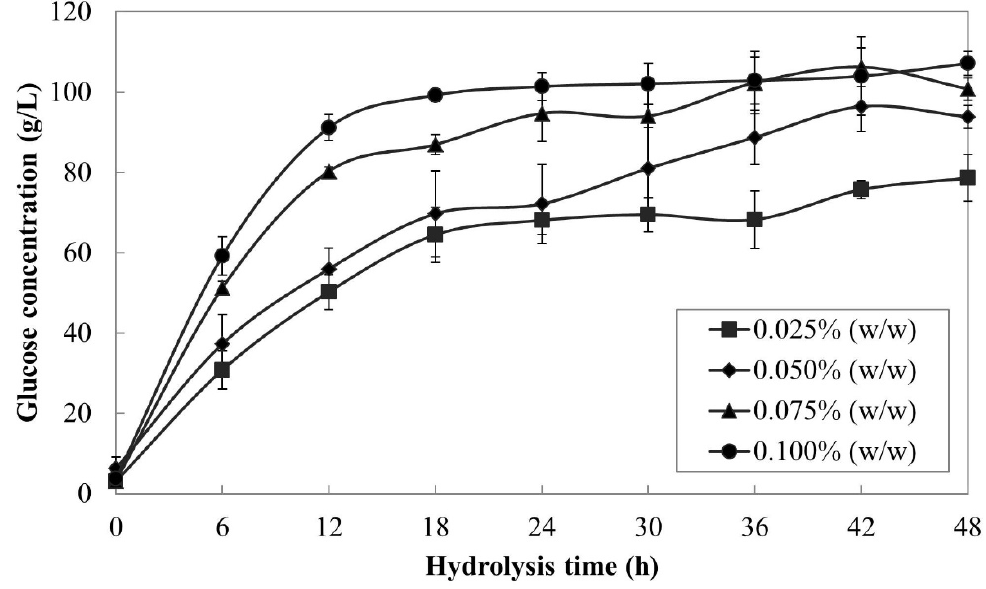
Figure 2. The e ff ect of StargenTM002 at concentrations of 0.025% (squares), 0.050% (diamonds), 0.075% Figure 2. The effect of StargenTM002 at concentrations of 0.025% (squares), 0.050% (diamonds), (triangles), and 0.100% (cycles) on liquefied starch hydrolysis at 40 ◦ C with a stirring speed at 300 rpm 0.075% (triangles), and 0.100% (cycles) on liquefied starch hydrolysis at 40 °C with a stirring speed at for 24 300 rpm for 24 h .